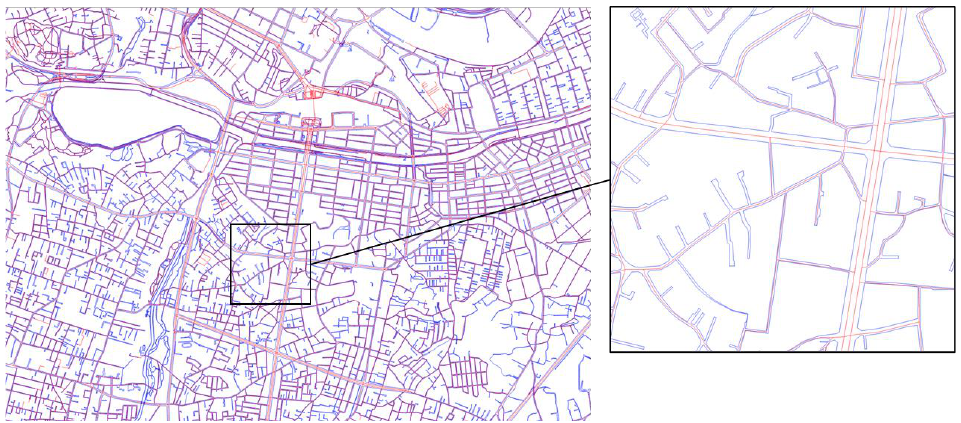
Figure 7. Superposition of GSI road edge map (blue) and OSM road centerline vector map (red) around Mito Station.